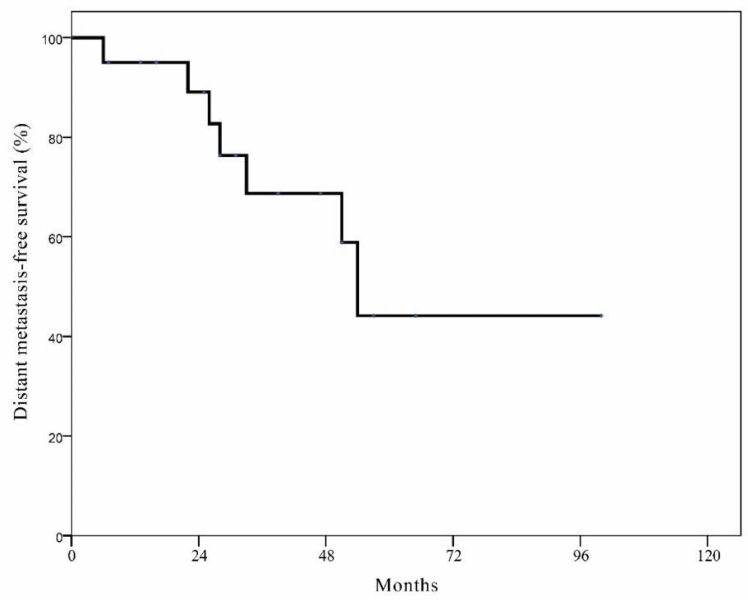
Figure 2. Kaplan-Meier curve of distant metastasis-free survival in patients with isolated local recurrence after breast conservation